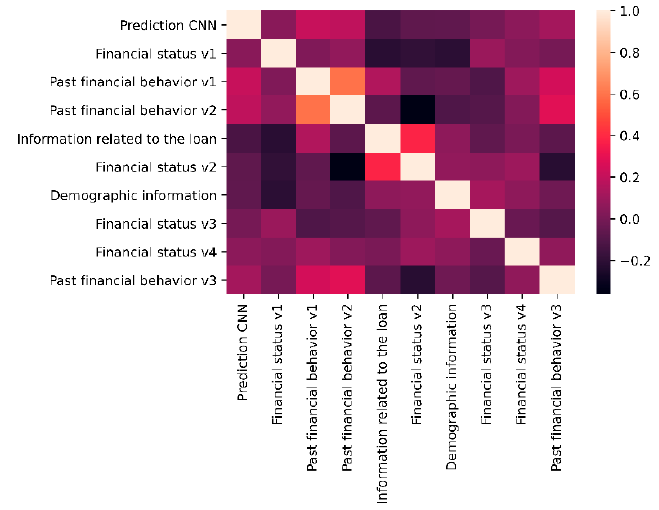
Figure 4. Correlation between predictions from the Deep Learning model based on Open Banking data (Prediction CNN) and the banks current explanatory variables for existing customers.